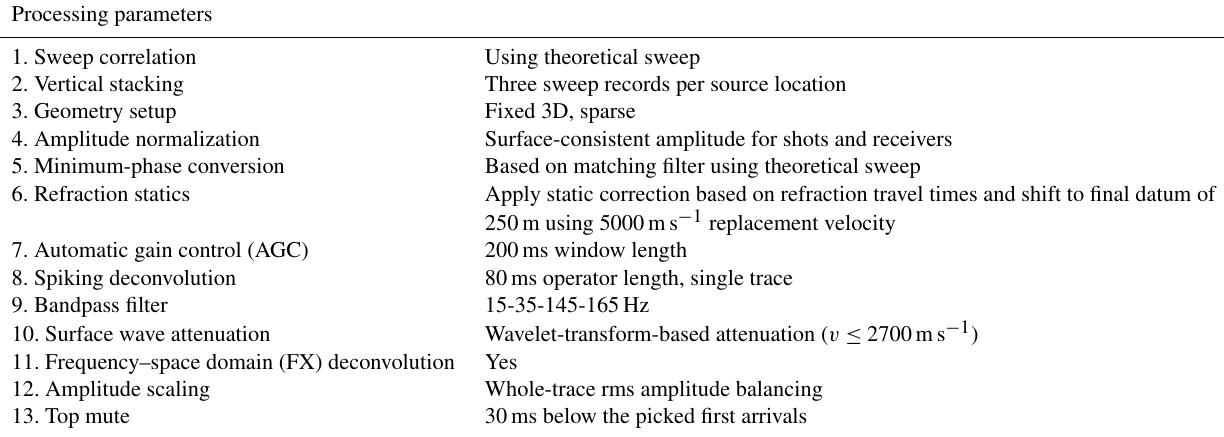
Table 2. Pre-processing flow applied to the dataset. All steps up to amplitude scaling are identical up to step 5 in the processing method given in Table 2 of Malehmir et al.